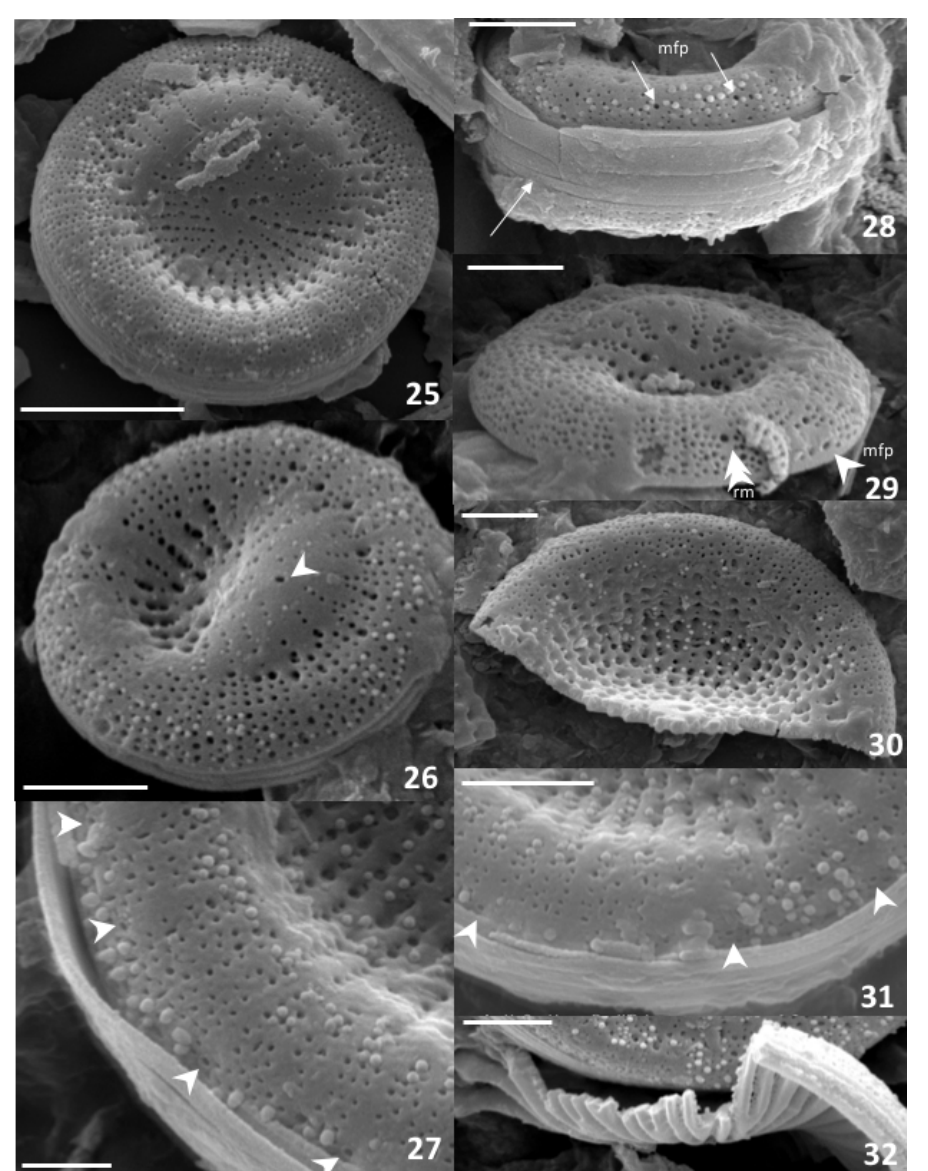
Figs 25–32. Type material of fossil lacustrine diatom Cyclocostis rolfii Paillès gen. et sp. nov.; SEM external valve views. 25 . Valve view of concentrically undulated marginal area and tangentially undulated central area; punctuated striae become in the central area rows of larger areolae arranged in a stellate pattern. 26 . Valve surface with scattered papillae; the external opening of the single valve face fultoportula is located on the raised part (white arrowhead). 27 . Marginal area showing the external openings of marginal fultoportulae, collared but with no projections (white arrowheads). 28 . Side view of marginal area showing striation, papillae, external openings of marginal fultoportulae (mfp – two white arrows), and the cingulum consisting of an open valvocopula and several copulae (white arrow). 29 . Detail of the central area with large areolae; external areolae are bigger and occluded by volae in places where ribs are fusing. 30 . Broken valve view showing the different striation between the margins and the center, the steep transversal undulation and the valve thickness. 31 . Marginal area with the external openings of marginal fultoportulae (white arrowheads), papillae, and the cingulum. 32 . Broken valve view showing the simple structure of anastomosing ribs covered by a finely perforated silica layer. Scale bars: 25 = 5 µm; 26, 28–32 = 2 µm; 27 = 1 µm ( 27